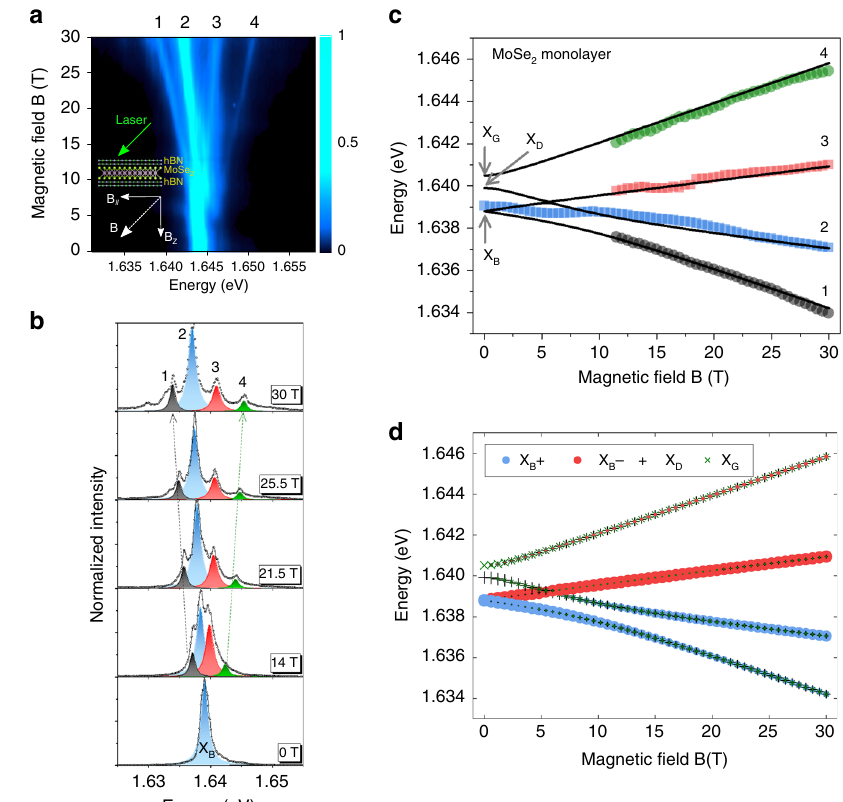
Fig. 3 Tilted (45°) magnetic fi eld — the four mixed excitons states (labeled 1, 2, 3, 4) in MoSe 2 monolayer revealed by magneto-photoluminescence. a Color map of the variation of the PL intensity as a function of B ; b PL spectra for magnetic fi elds from 0 to 30 T showing the emergence of the four mixed states (the intensity is normalized to the main exciton line (state 2)). c Magnetic fi eld dependence of the energy of the four mixed exciton states. The full lines are fi ts to the model described in the text. The notations dark exciton (X D ), gray exciton (X G ) and bright excitons (X B ) are only strictly valid at 0 T. d Same fi tting results than in c . The size of each symbol is proportional to the weight of each component (the two bright component X B + and X B − and the two dark component X G and X D ) (see Supplementary Note 7 for the calculation of the weight of the four components at high fi